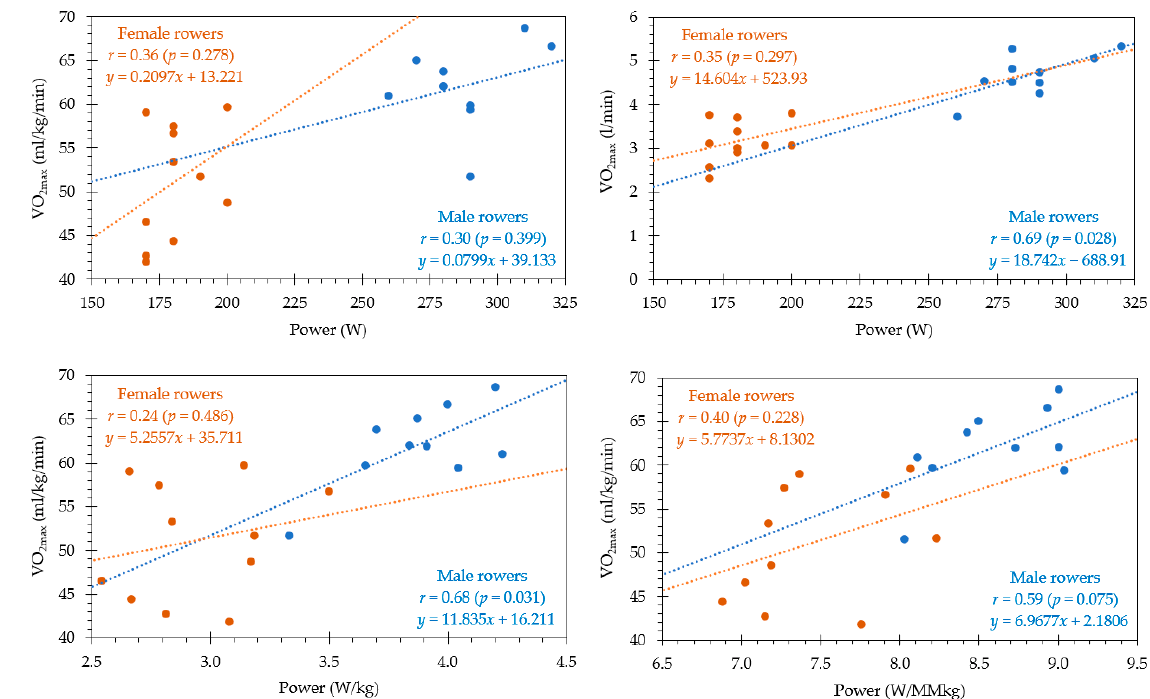
Figure 2. Relationships between VO 2max and rowing performance in female and male rowers.